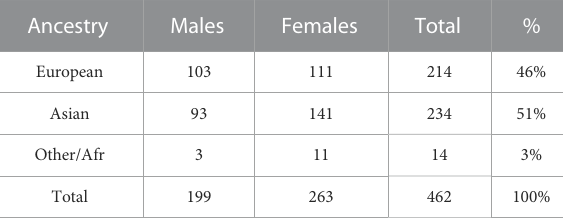
TABLE 4 Gender of 462 affected children by self-reported ancestry.